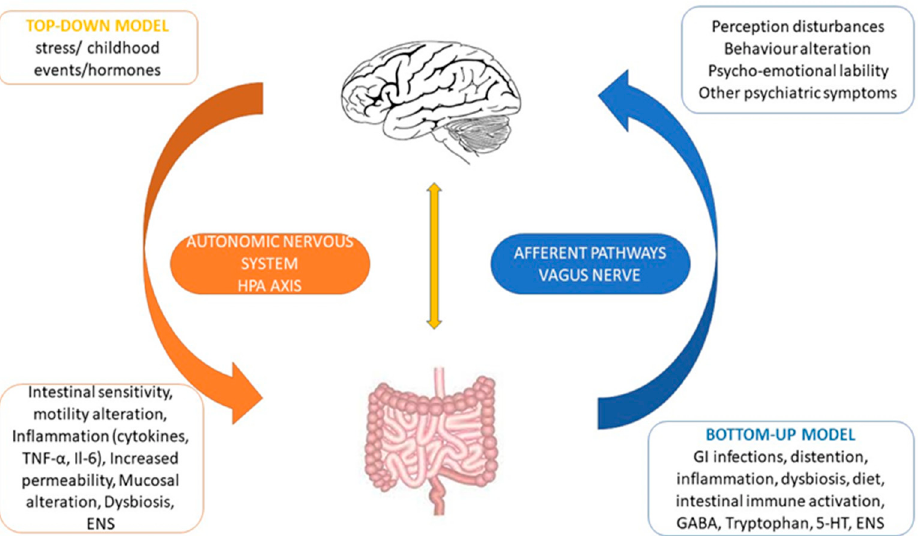
Figure 1. Generic aspect of the bidirectional mechanism of the gut–brain axis (rebuild after Physio- Pedia: https://www.physio-pedia.com/File:Gut_Brain_Microbiome_Axis.png accessed 26.03.2022 ).